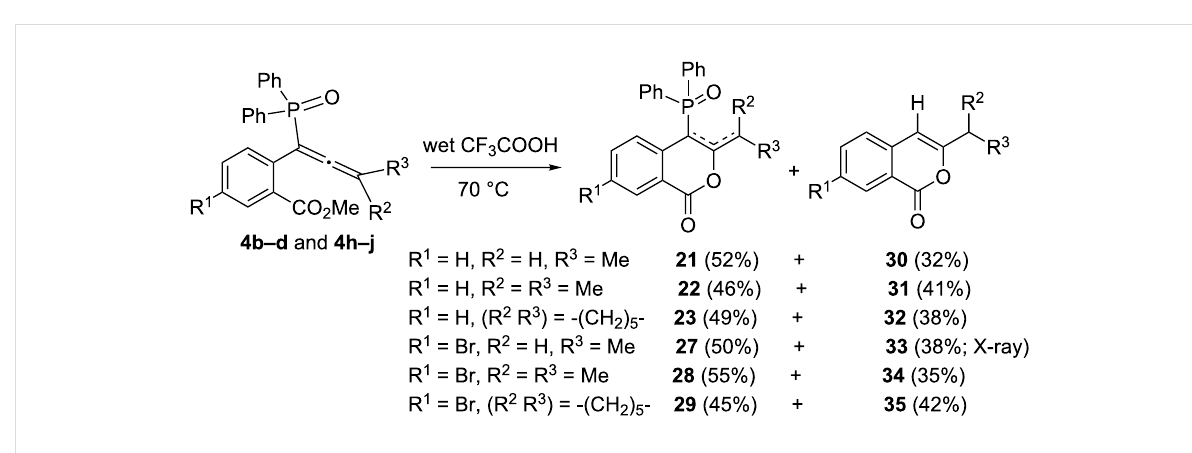
Scheme 8: Possible pathway for the formation of phosphinoylisocoumarins.